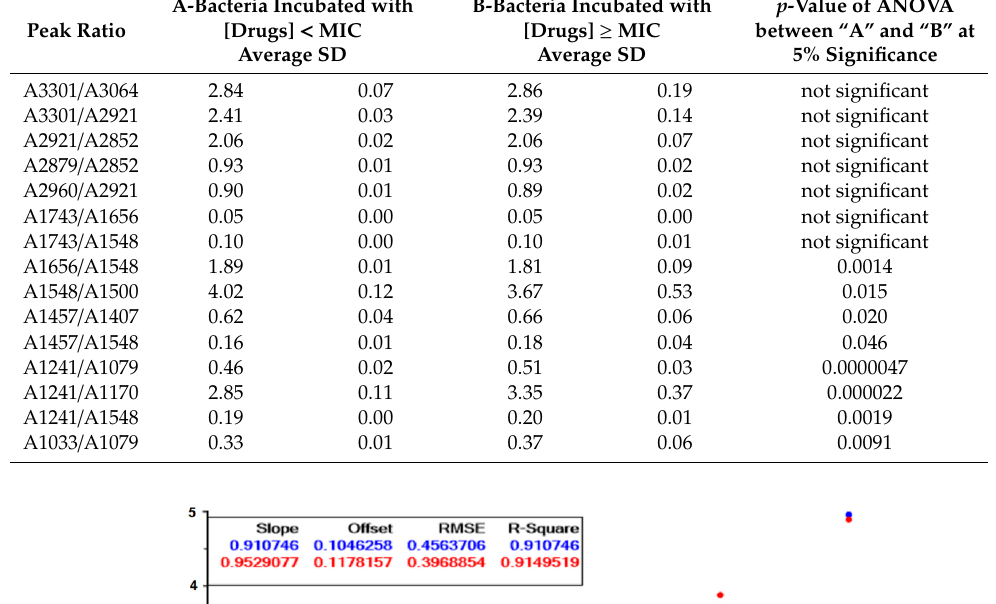
Table 4. Average values and standard deviation of peak ratios from the J99 H. pylori spectra and the p -value at 5% significance from ANOVA between the incubations with clarithromycin concentrations lower or higher to the MIC.